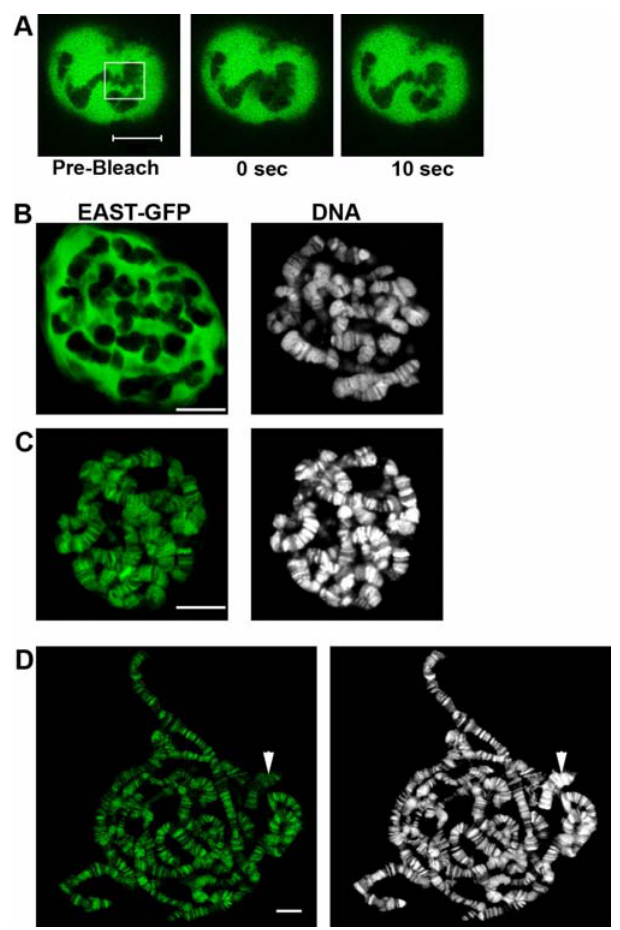
Figure 1. EAST can associate with Polytene Chromosomes. (A) Live intact salivary glands expressing EAST-GFP (green) were exposed to photobleaching. A rapid recovery (see Figure 3E) indicates a high mobility in the nucleoplasm. (B-D) Larval salivary glands expressing EAST-GFP (green) were fixed and counterstained with TOPRO3 (white) to visualize DNA. (B) In untreated cells, EAST-GFP is localized to extrachromosomal nuclear regions. (C) In larval salivary permeabilized with a saponin containing detergent buffer, EAST-GFP rapidly relocates to the polytene chromosomes. (D) In detergent treated and squashed preparations of polytene chromosomes, EAST-GFP shows a high degree of co-localization with DNA bands. The chromocenter is indicated (arrow head). EAST-GFP represents full length EAST with a C-terminal eGFP tag that was expressed by the GAL4 system using the smid-Gal4 driver. Bars correspond to 10 m m in all panels.